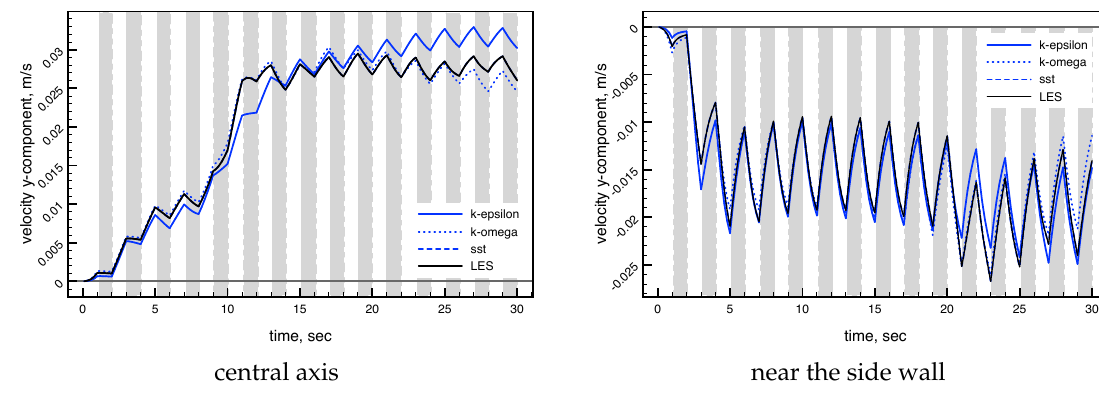
Figure 9. Turbulence models